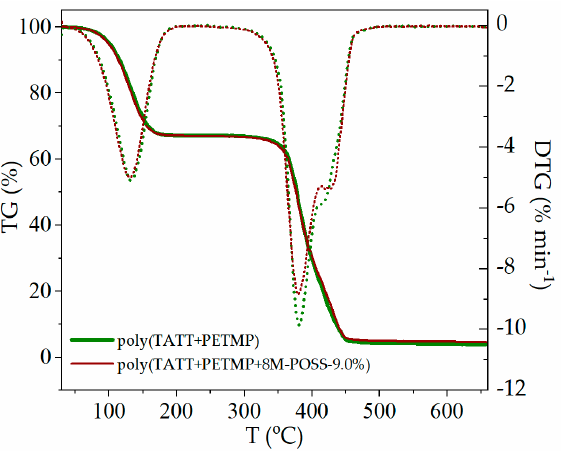
Figure 8. TG and DTG curves of ionogels with 70 wt.% of EMImNTf 2 and PC mixture. TG—solid line, DTG—dotted line.